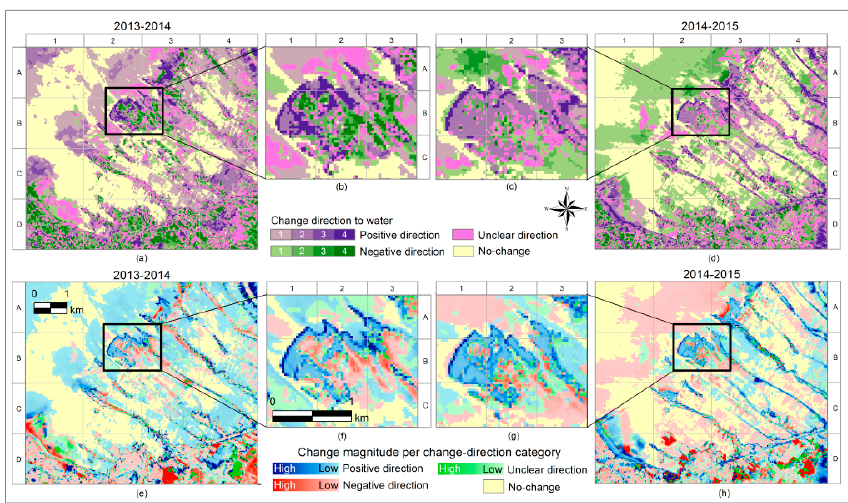
Figure 7. The representation of shoreline change direction: in the period 2013–2014 ( a , b ); and in the period 2014–2015 ( c , d ). Darker color pixels show a higher frequency of change to a certain direction. Shades of violet pixels depict a positive direction to water membership while shades of green pixels illustrate a negative direction to water membership. Figures in the second row show the magnitude of each change direction category in the period 2013–2014 ( e , f ); and in the period 2014–2015 ( g , h ). Darker color pixels represent a higher change magnitude while lighter color pixels show a lower change magnitude.